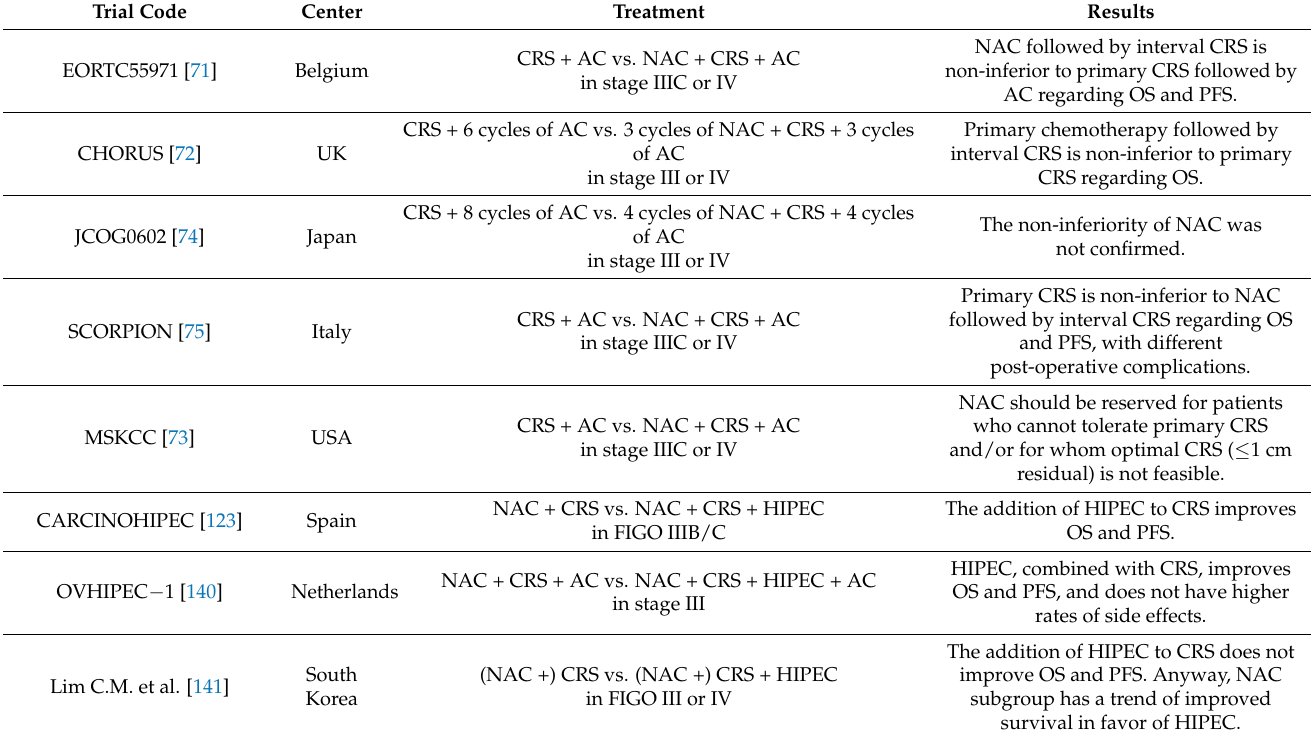
Table 2. Completed trials. CRS: cytoreductive surgery; AC: adjuvant chemotherapy; NAC: neoadju- vant chemotherapy; HIPEC: hyperthermic intraperitoneal chemotherapy; OS: overall survival; PFS: progression-free